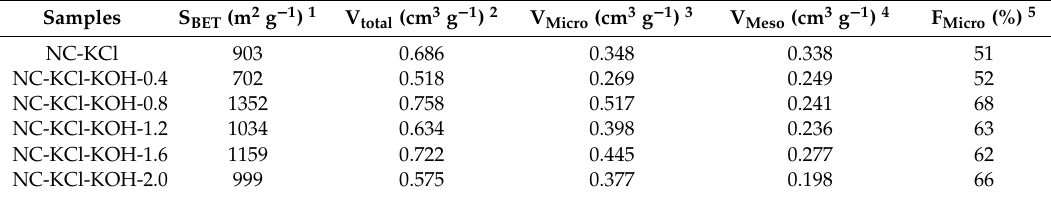
Table 8. BET surface area and porosity of samples activated by di ff erent amount of KOH and 0.75g KCl per 2.20 g resorcinol.